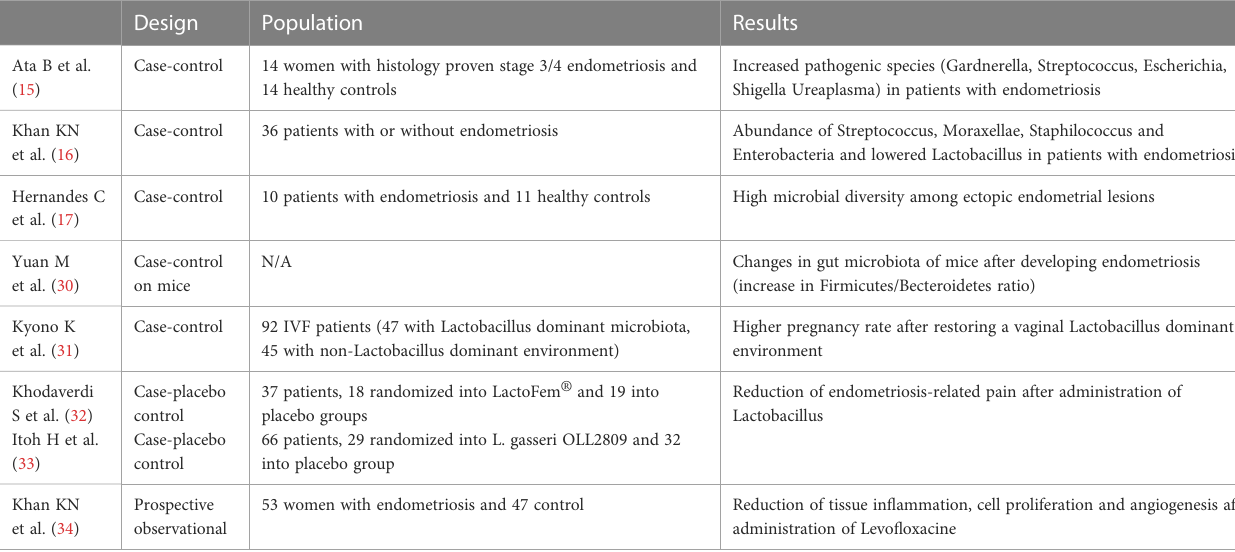
TABLE 1 Main studies that have related endometriosis with microbioma alterations.